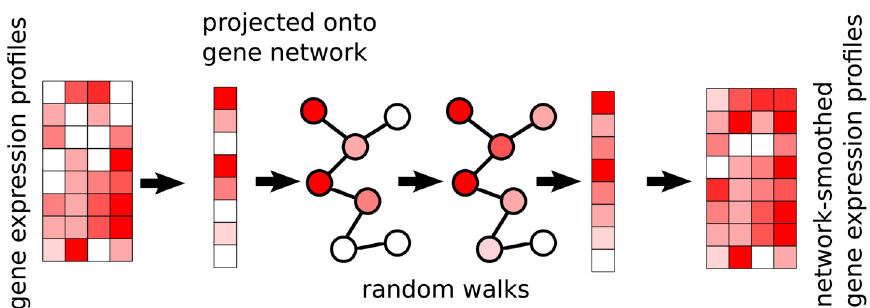
Figure 1. The netSmooth algorithm takes a gene expression profile, and a gene network. The expression profile of each sample is projected onto the network, where a diffusion process allows genes’ expression values to be smoothed by their neighbors’. This is done for each cell independently of others. The end result is a network smoothed gene expression